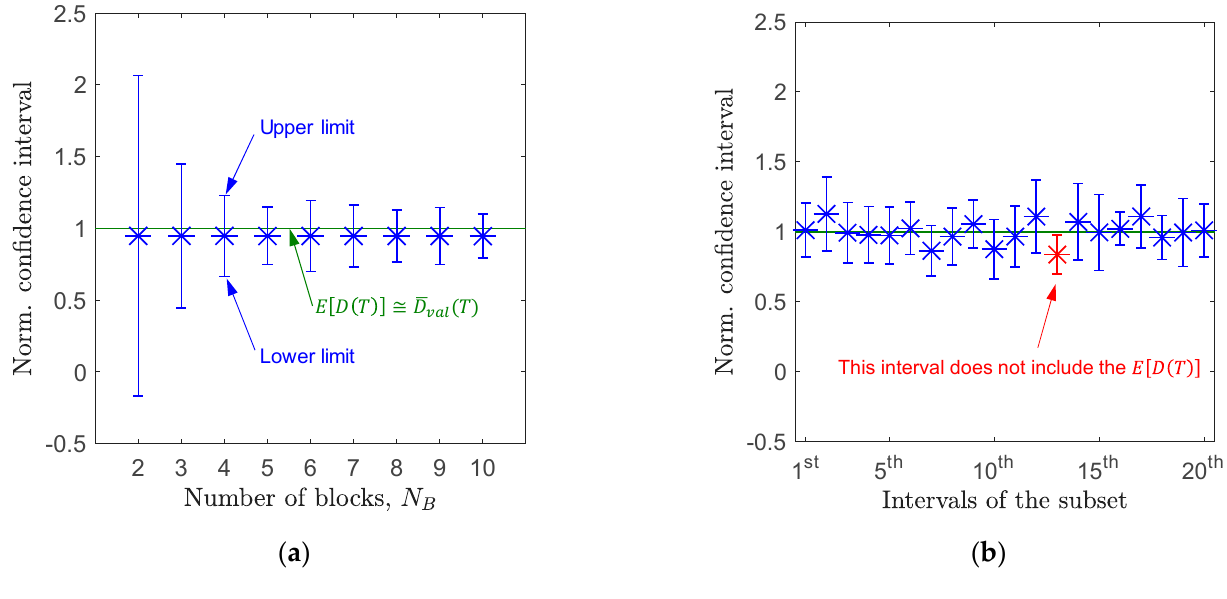
Figure 5. Load A: ( a ) confidence intervals versus number of blocks 𝑁 (cid:3003) ; ( b ) sample of 20 confidence intervals for case 𝑁 (cid:3003) = 10 .